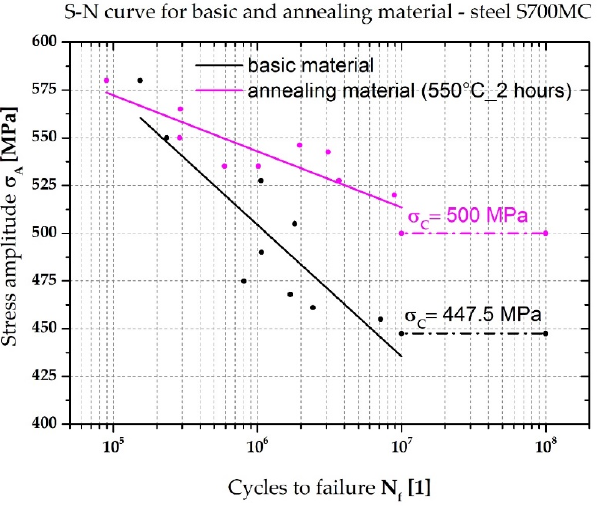
Figure 6. The final S–N curve of the base and annealed materials of S700MC steel. Table 3. Fatigue test results for base material S700MC and annealed